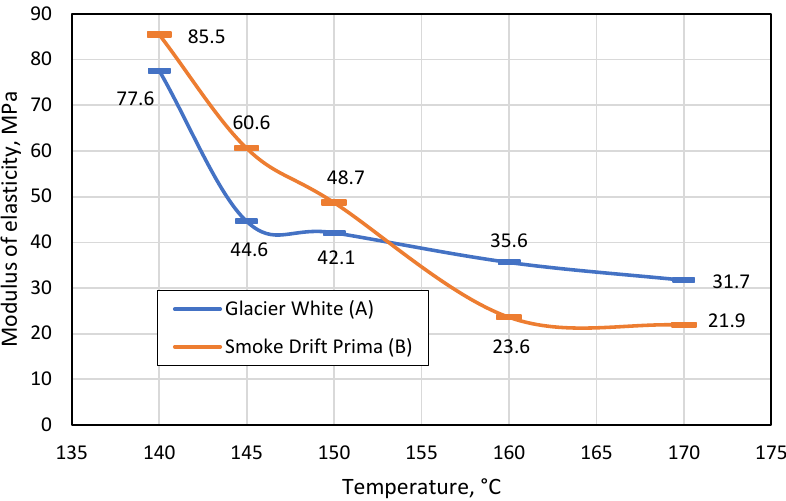
Figure 7. Change in modulus of elasticity (MPa) of monochrome A and patterned B materials with changing temperature.